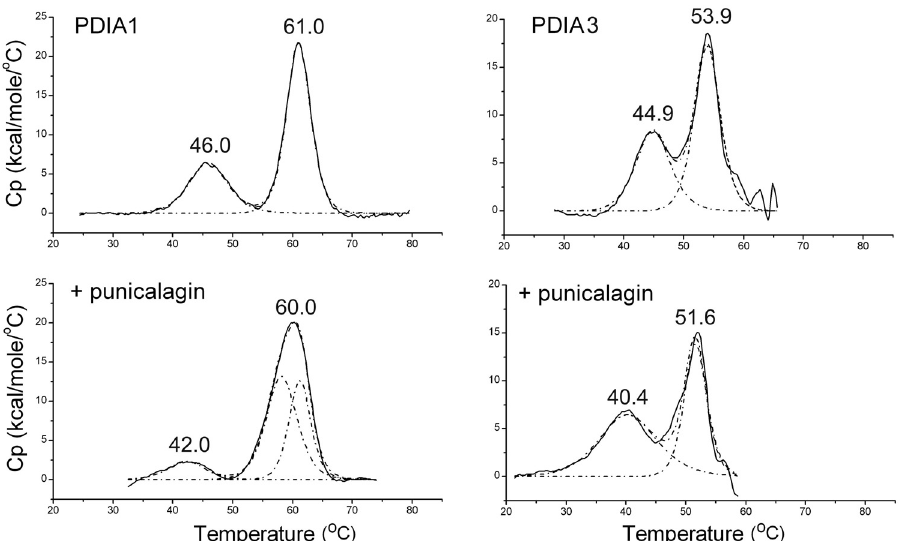
Figure 3. Thermal denaturation profiles of reduced PDIA1 and PDIA3 obtained by DSC. Proteins, 5 µM concentration, were analyzed in the absence and presence of 25 µM punicalagin. The transition temperature (T m ) of each endothermic peak is reported. The dotted lines show the best fit obtained by deconvolution of each thermogram in non-two-state transitions.